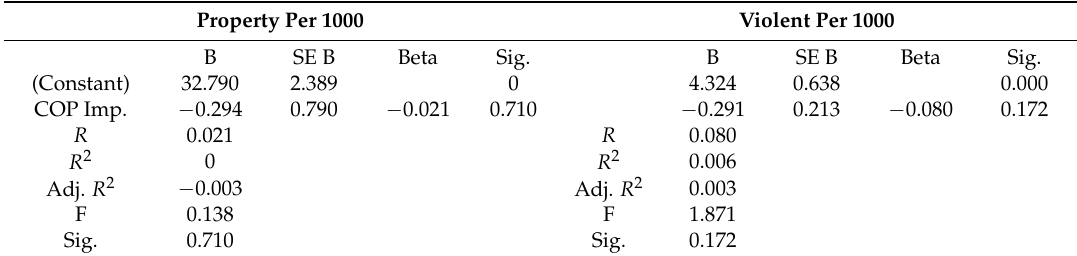
Table 3. Regression Model for COP Composite Variable ( n =